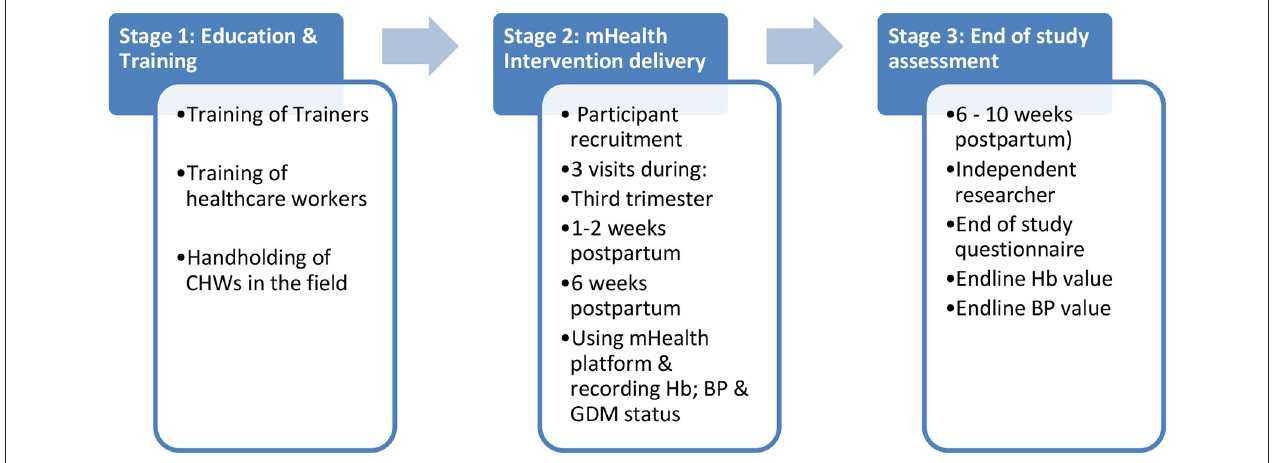
FIGURE 2 | Stages in SMARThealth pregnancy